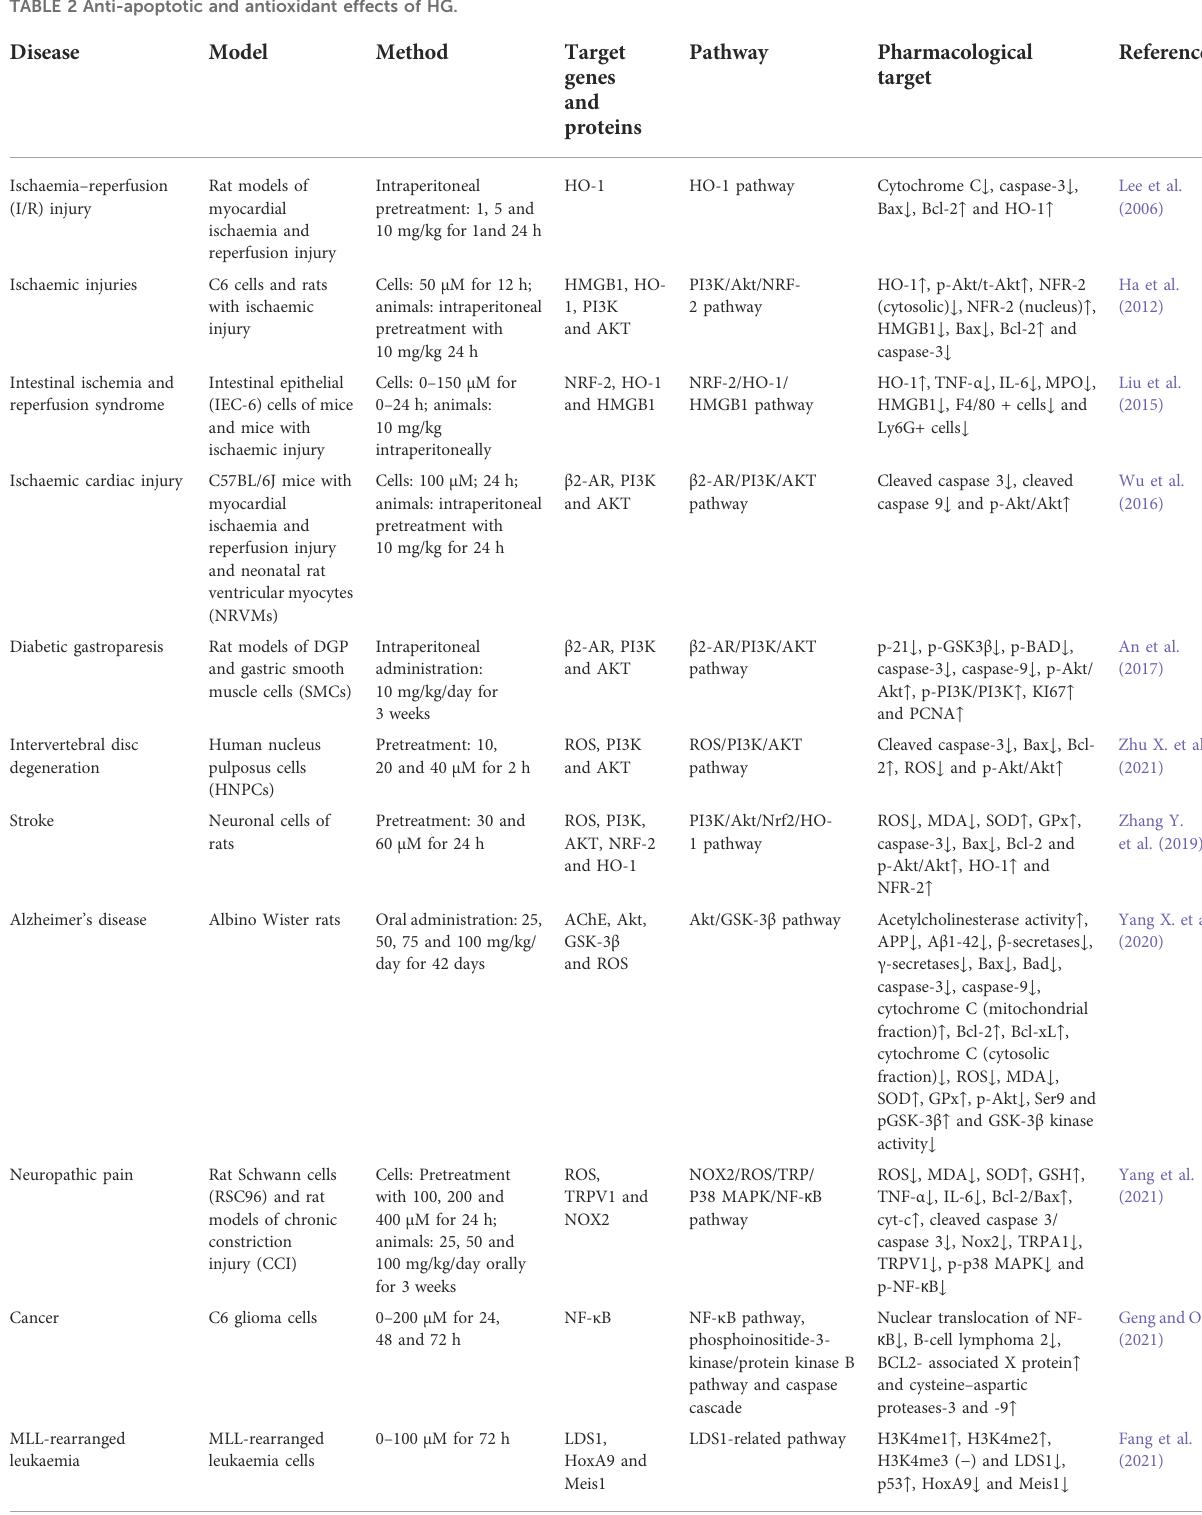
TABLE 2 Anti-apoptotic and antioxidant effects of